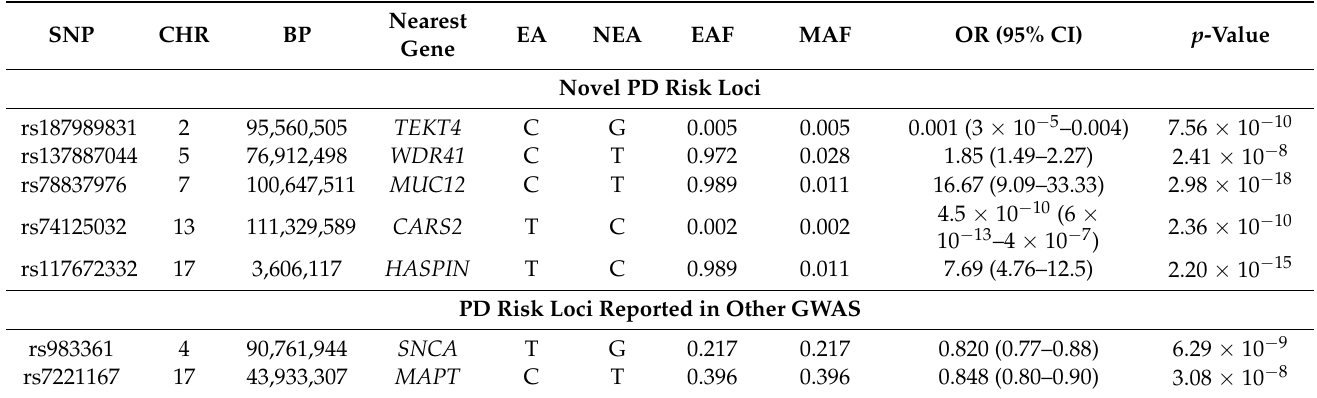
CHR = chromosome; BP = base position in GRCh37 (hg19); OR = odds ratio; EA = effect allele; NEA = non-effect allele; EAF = effect allele frequency; OR (95% CI) and p -value = odds ratio (95% confidence interval) and p -value from association